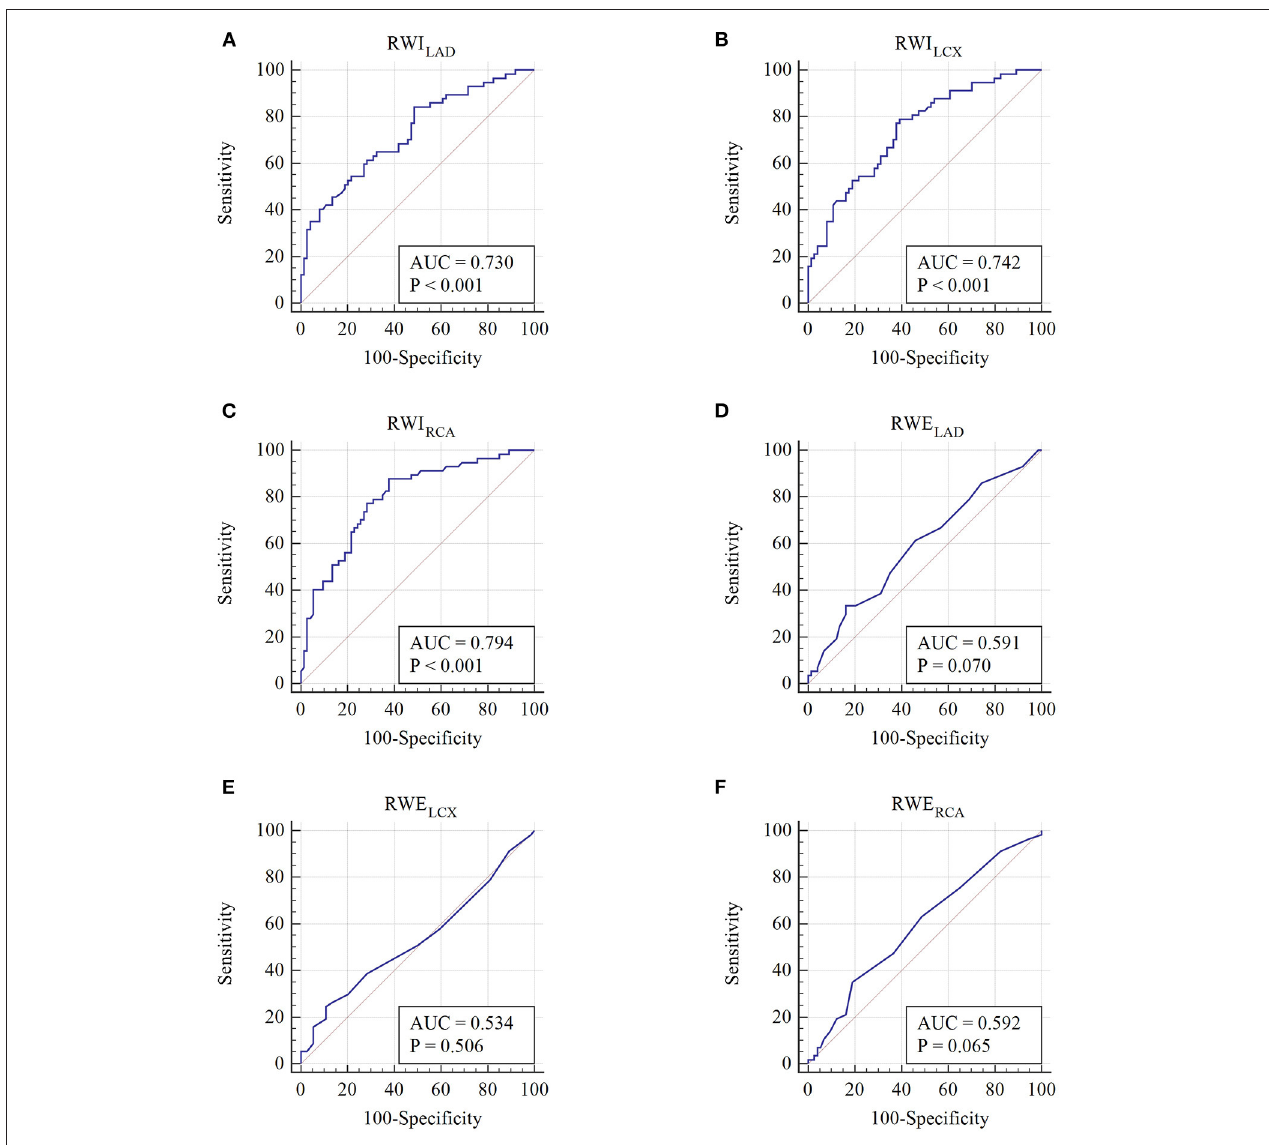
FIGURE 3 | Receiver operating characteristic curves of each regional MW parameter. (A–F) Receiver operating characteristic curves of RWILAD, RWILCX, RWIRCA, RWELAD, RWELCX, and RWERCA, respectively.